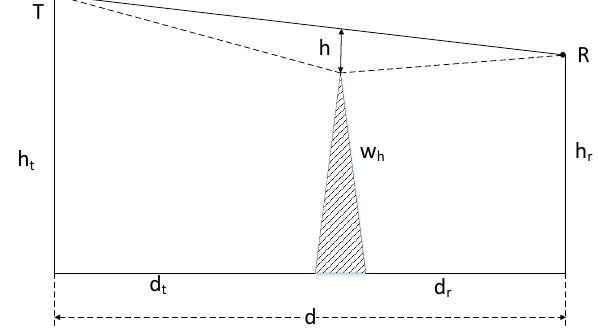
Figure 6. The diagram of the clearance parameter.